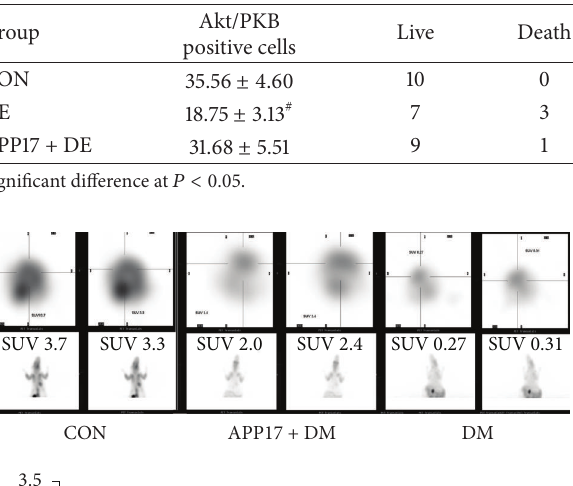
Table 3: The number of positive cells of neurons in hippocampus of rats in 3 groups ( 𝑥 ± 𝑠 ).